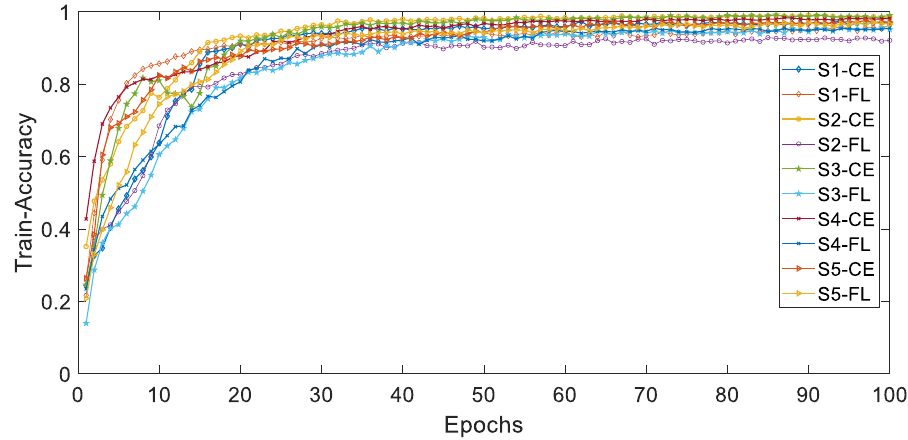
Figure 4. The curve of accuracy with training set.